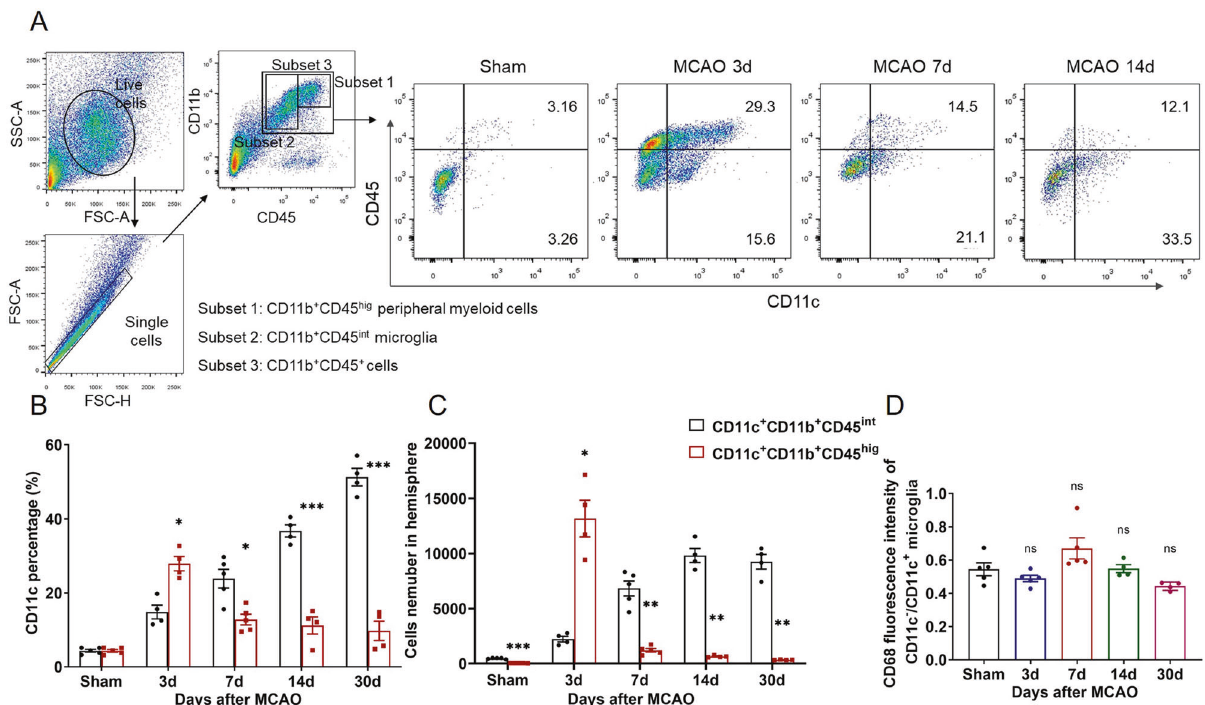
Fig. 4 CD11c + microglia continually increased from Day 7 to Day 30 after stroke. A Gating strategy to distinguish peripheral in fi ltrated myeloid cells and resident microglia (left). Representative fl ow cytometric analysis for the expression of CD11c in CD11b + CD45 + cells in sham, tMCAO 3, 7, and 14 Day groups. B Percentage and C cell number of CD11c + peripheral cells and CD11c + microglia during Subset 3 in sham, tMCAO 3, 7, 14, and 30 Day groups. n ≥ 4 per group. D The ratio of CD68 fl uorescence intensity in CD11c − to CD11c + microglia. n ≥ 4 per group. B , C Compared to CD11c + CD11b + CD45 int group. D Compared to the sham group. * p < 0.05, ** p < 0.01 and *** p < 0.001. Values were mean ±